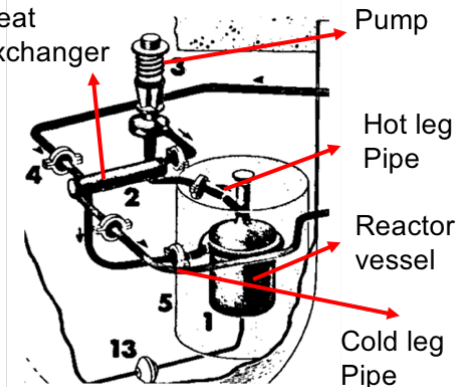
Figure 1. Schematic of the MSRE primary loop